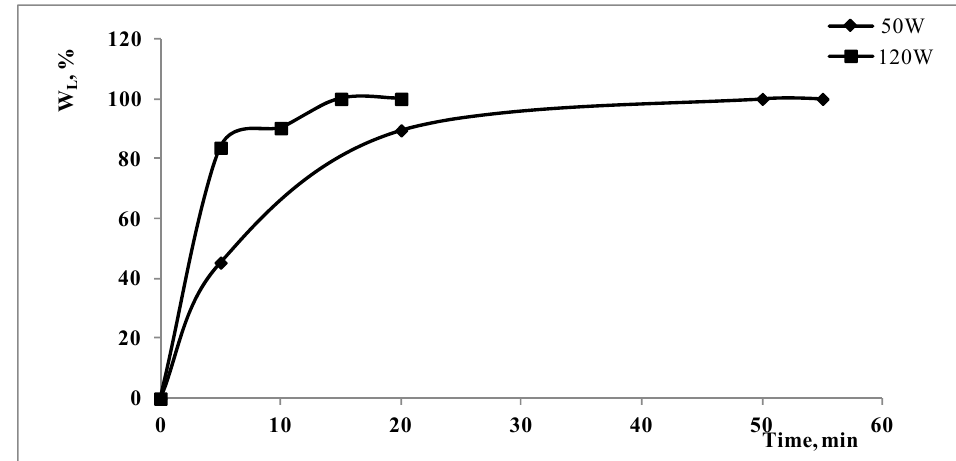
Figure 3. Percentage weight loss during the ultrasonic treatment at the ammonia concentration of 0.75%, at the temperature of 50 °C and at two different levels of power of the ultrasonic bath.